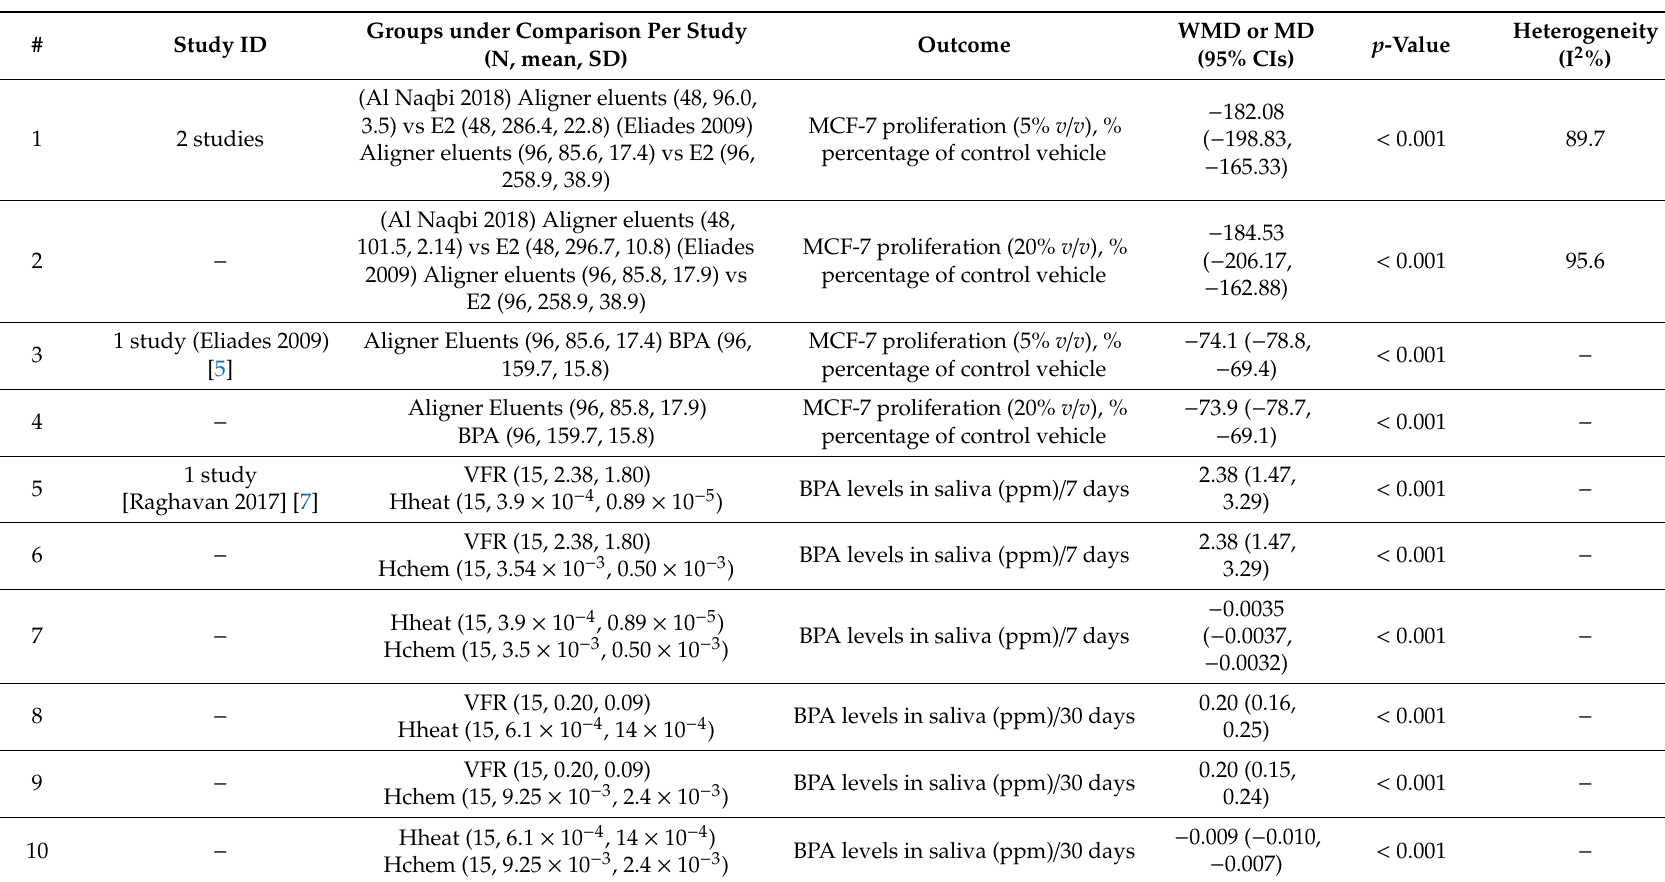
Table 3. Quantitative data from meta-analyses and individual single studies for related groups under comparison and outcomes. The minus sign (-) shows lower e ff ect for the first reported group. Bold indicate statistically significant